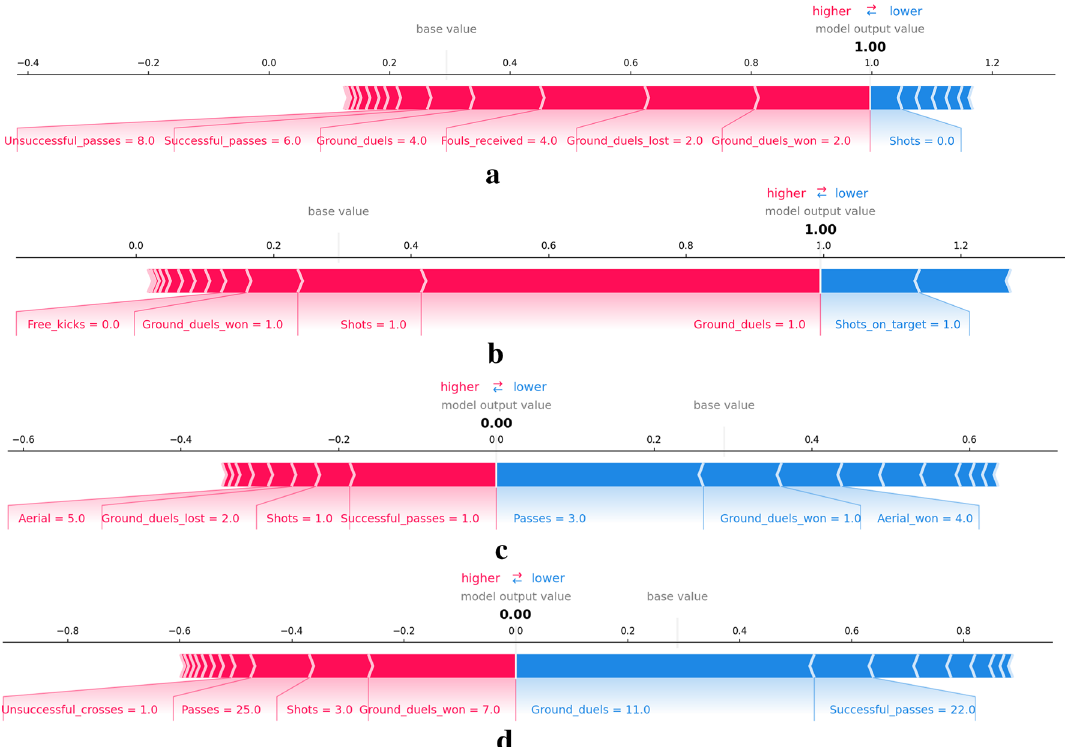
Figure 3. SHAP force plots explaining the predicted gender of four players of the data set with female class as the reference, the model output value is the probability of that instance to be classified as class female. The base value indicates the expected value for female classes. For female predictions ( a ) and ( b ), the explainer outputs a 1.00 probability while for male predictions ( c ) and ( c ) the probability is 0.00. Red arrows indicate positive Shapley values increasing the probability and blue arrows indicate negative values decreasing the probability.